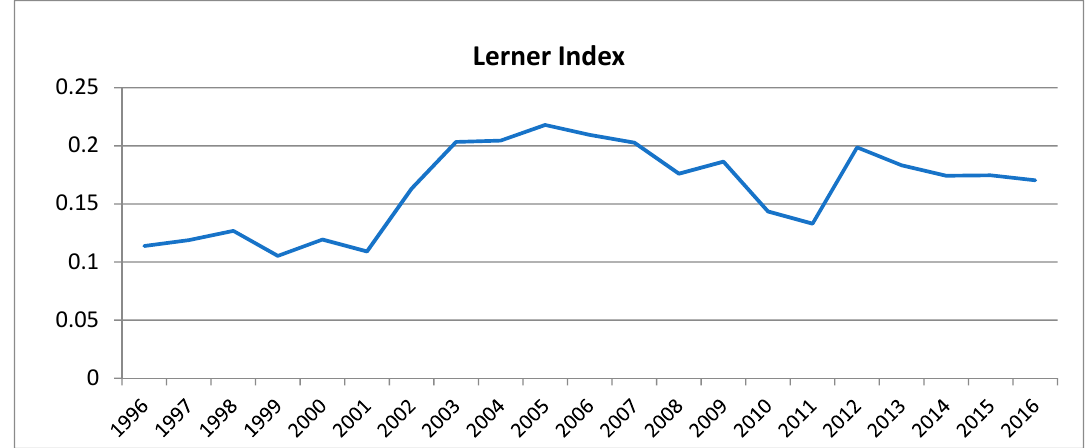
Figure 2. Lerner Index for the Period 1996–2016.